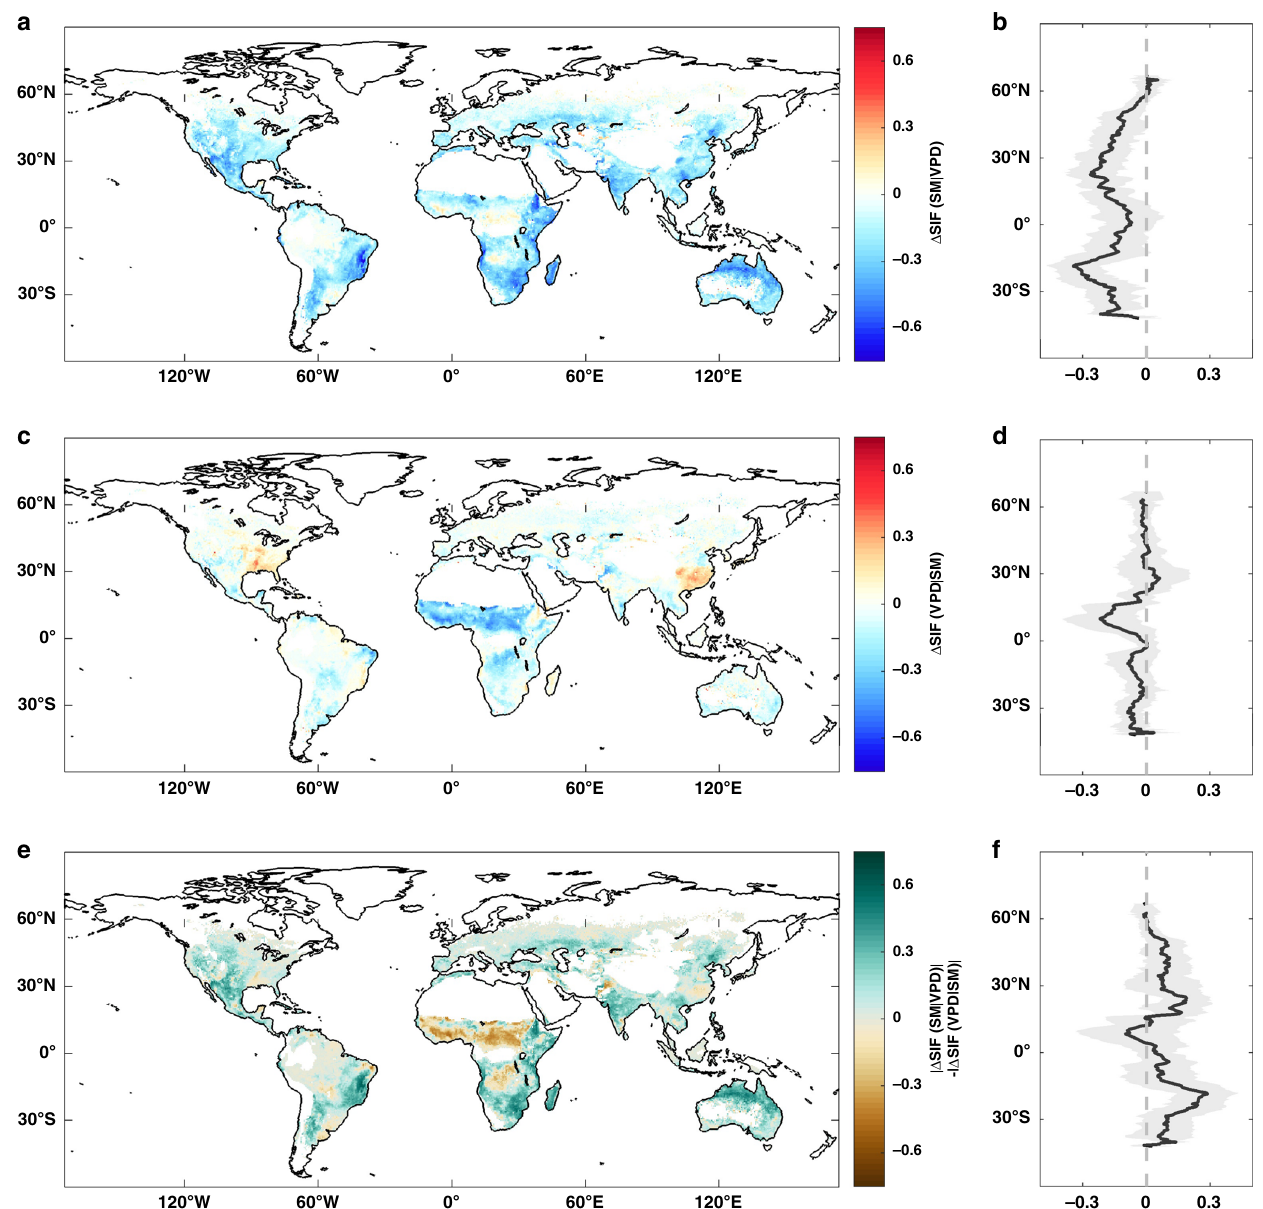
Fig. 4 Effect of soil moisture and vapor pressure de fi cit on ecosystem production globally. a , c , e Spatial distribution of the changes in solar-induced chlorophyll fl uorescence (SIF) caused by low soil moisture (SM) ( Δ SIF(SM|VPD)) and high vapor pressure de fi cit (VPD) ( Δ SIF(VPD|SM)), and their differences in absolute values (i.e., | Δ SIF(SM|VPD)| − | Δ SIF(VPD|SM)|). b , d , f Zonal means of SM and VPD effects on SIF and their differences in absolute values. The units refer to the fractions relative to average SIF exceeding the 90th percentile in each grid cell. Black lines indicate the mean values, and gray shaded bands show the standard deviation. Regions with sparse vegetation and regions without valid data are masked in